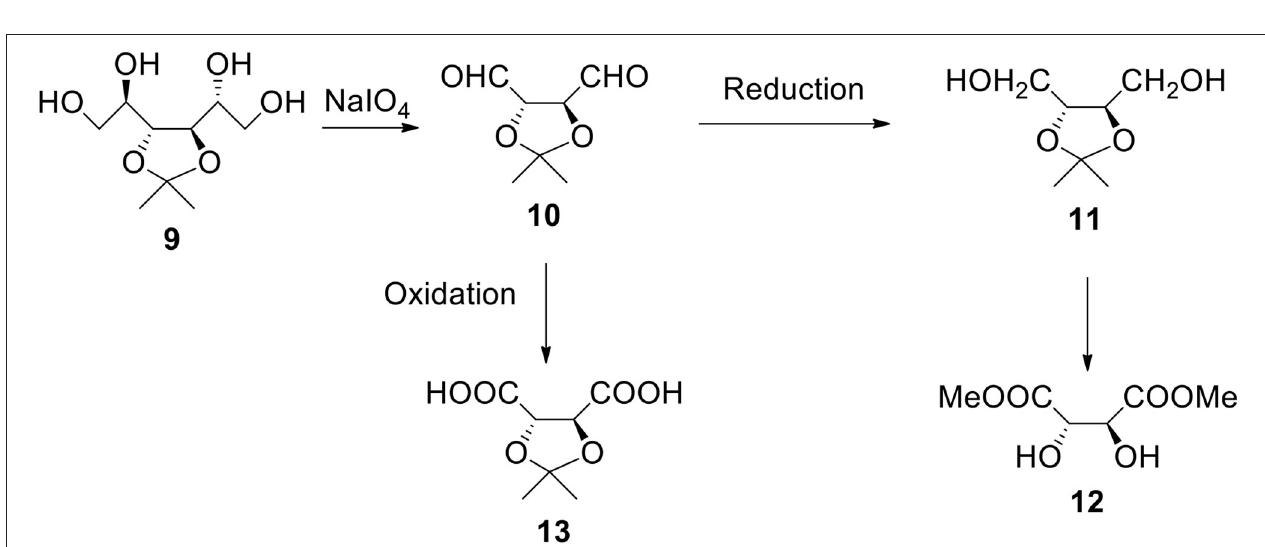
FIGURE 4 | Synthesis of α , ω -bifunctional compounds (diols and diacids) starting from 3,4- O -isopropylidene-D-mannitol 9 .